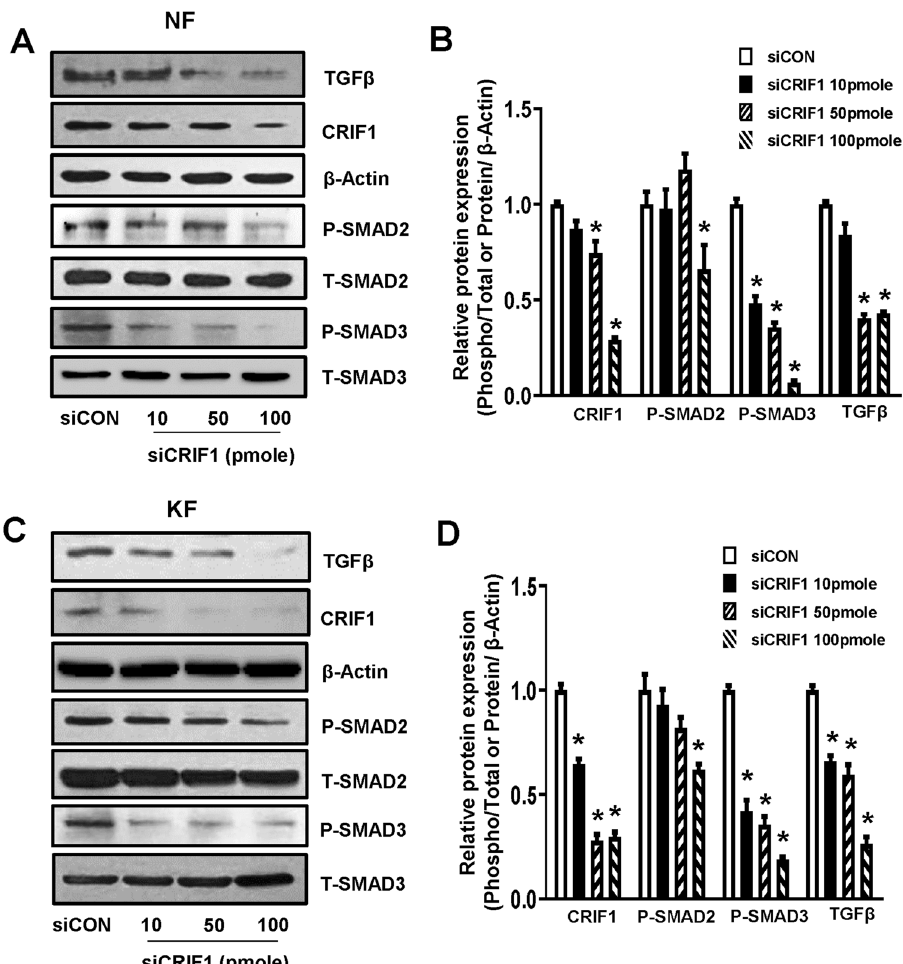
Figure 6. The TGF-β/Smad pathway is altered by CRIF1 downregulation in normal fibroblasts (NFs) and keloid fibroblasts (KFs). ( A ) NFs were transfected with CRIF1 siRNA in a dose-dependent manner for 48 h. After 48 h incubation, cells were harvested, lysed, and analyzed by western blot to assess differences in protein levels of TGF-β, P-Smad2, and P-Smad3; β-actin was used as the loading control. Full-length blots are presented in Supplementary Fig. S5a. ( B ) Protein density was calculated using ImageJ software. ( C ) KFs were transfected with CRIF1 siRNA in a dose-dependent manner for 48 h. After 48 h incubation, cells were harvested, lysed, and analyzed by western blot to assess differences in protein levels of TGF-β, P-Smad2, and P-Smad3; β-actin was used as the loading control. Full-length blots are presented in Supplementary Fig. S5b. ( D ) Protein density was calculated using ImageJ software. All data are presented as the mean ± SD of three independent experiments. * P < 0.05 compared to